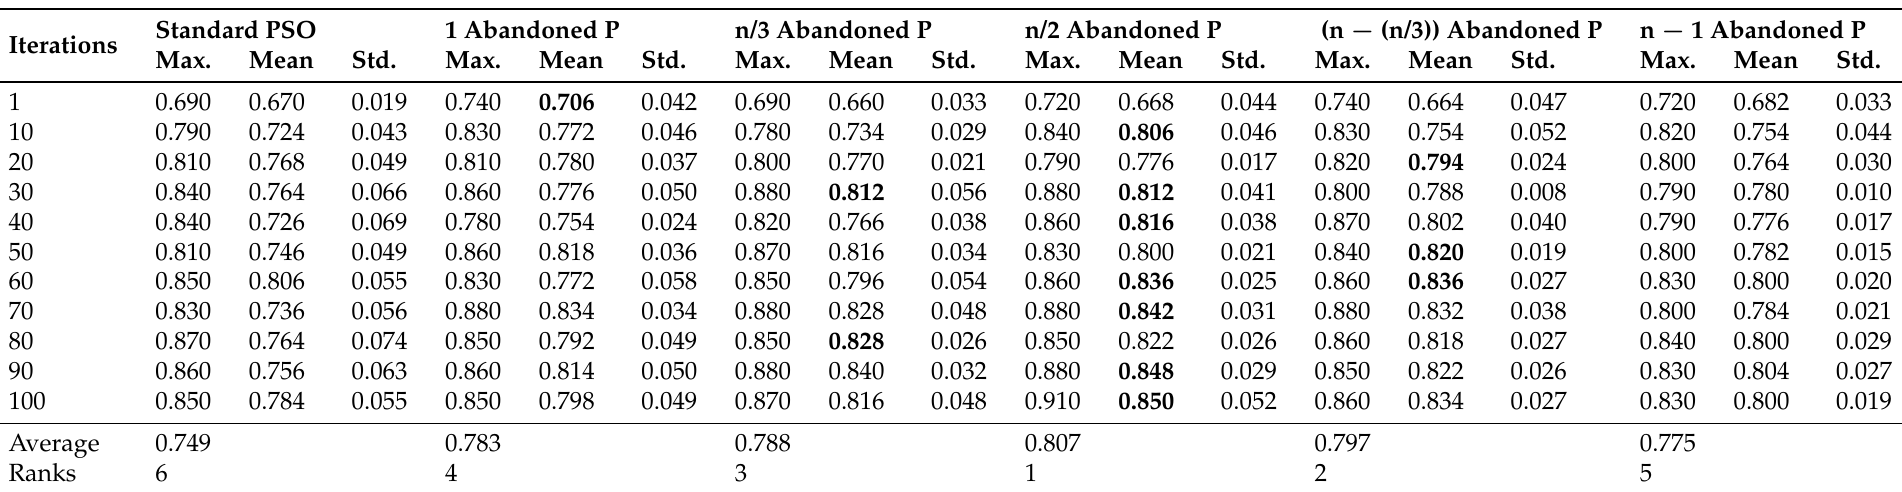
Table 3. Different number of abandoned particles with least solutions of subswarm-PSO for 10